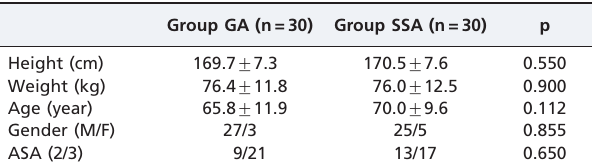
Table 1 - Demographic data.